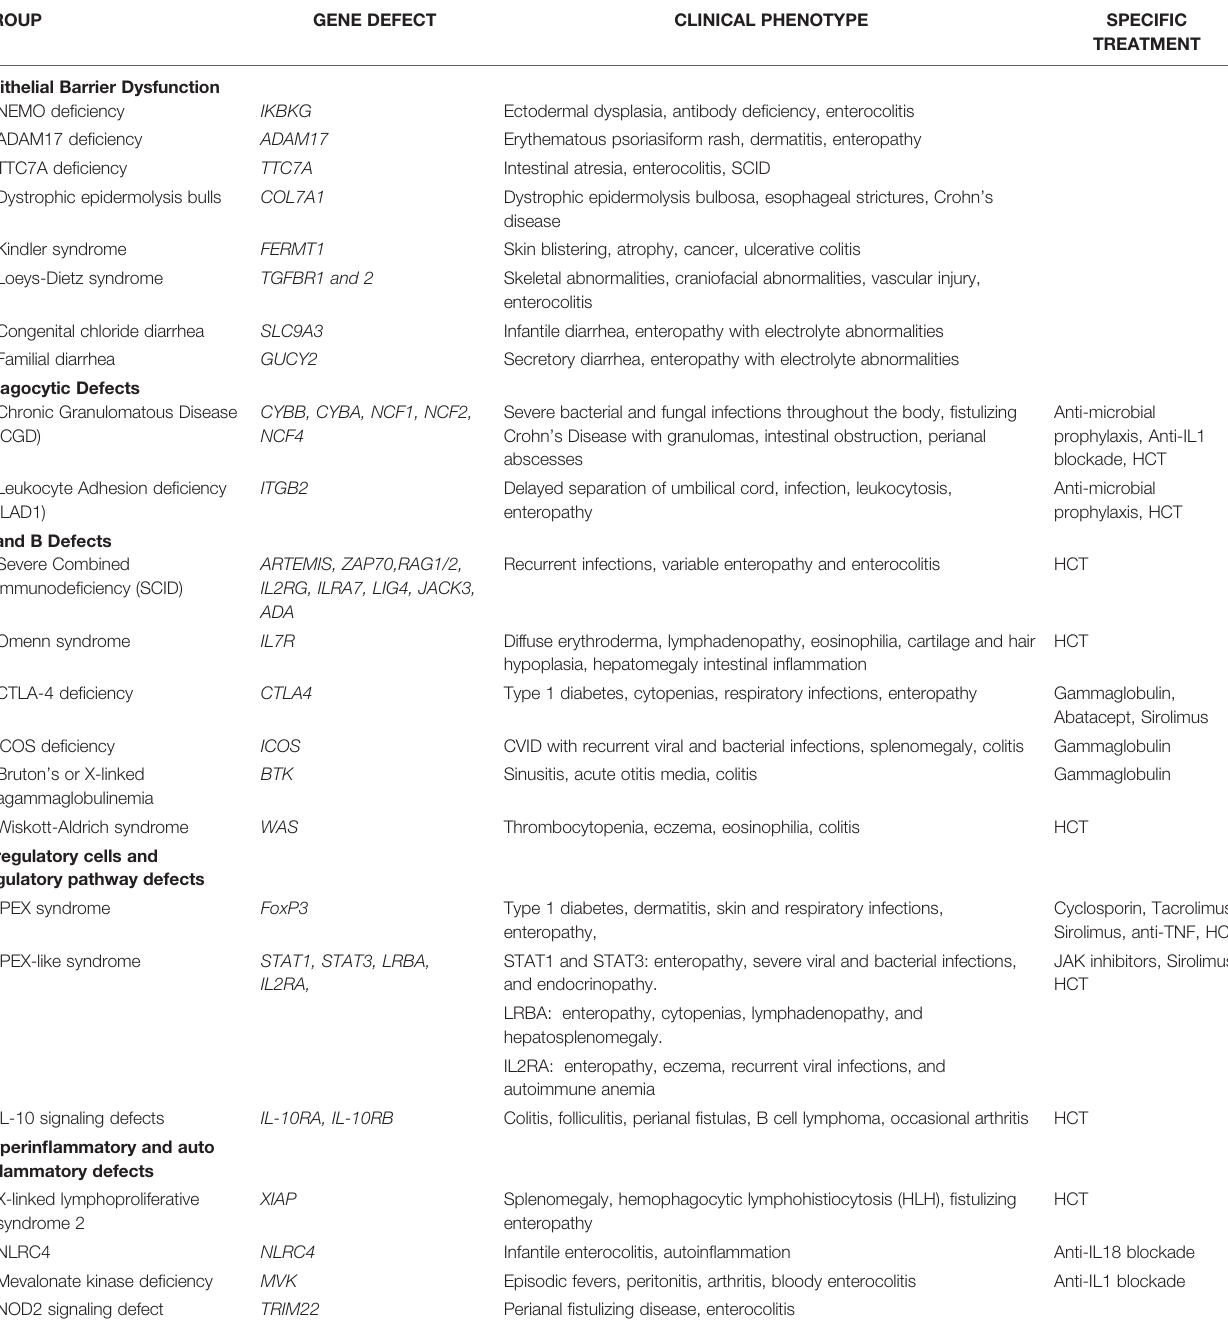
TABLE 1 | Genetic and clinical manifestations in VEO-IBD.